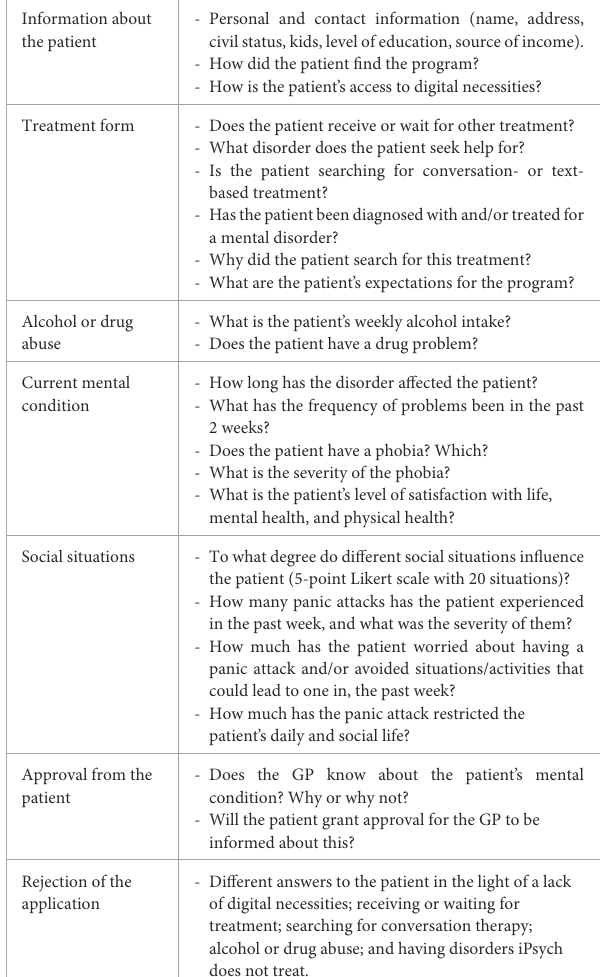
TABLE 1 Request form